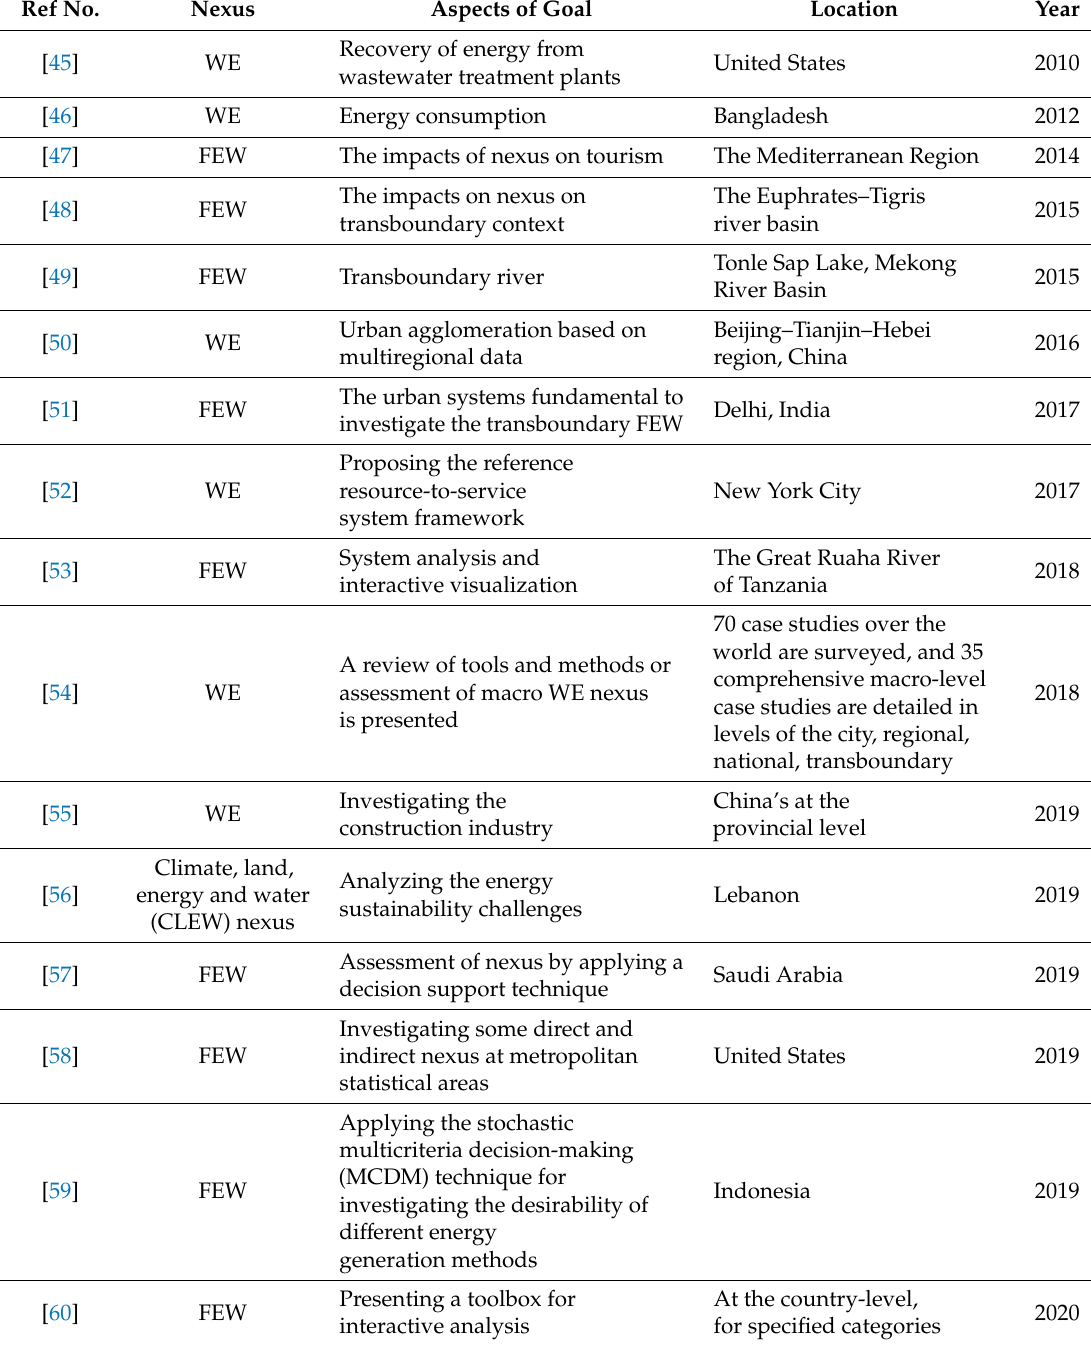
Table 3. Brief data on some highlighted real case studies on di ff erent nexus. Ref